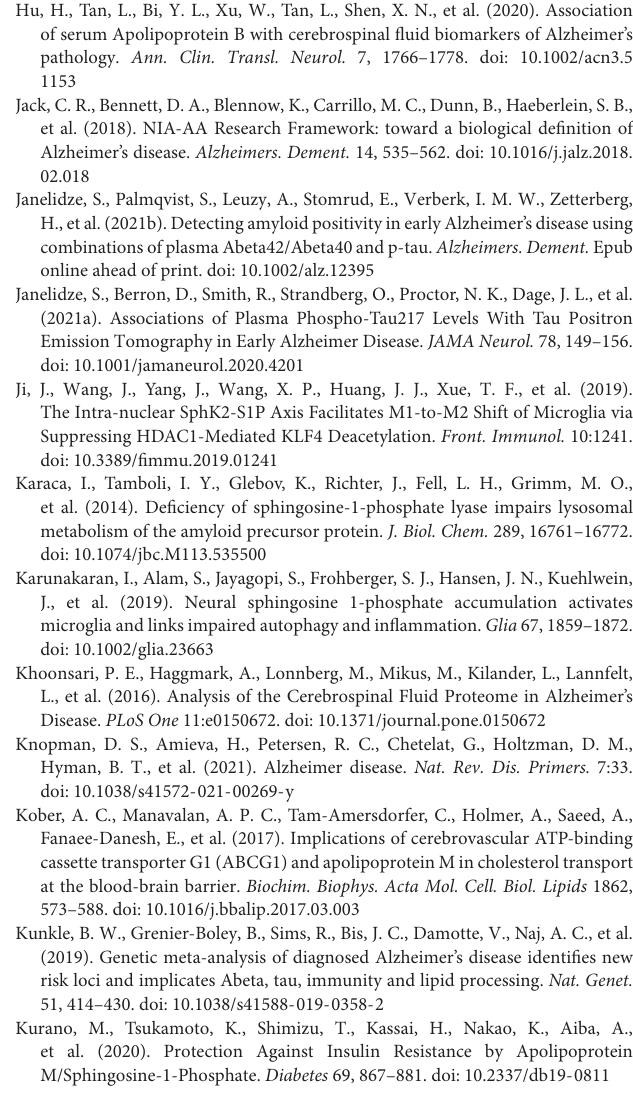
using Spearman’s rank correlation. p < 0.05 was considered the statistical significance. Supplementary Figure 4 | Correlations between plasma ApoM and its-derived indicators with representative blood biomarkers of AD in subgroup analysis based on APOE ε 4 status. ApoM, apolipoprotein M; p-tau217, tau phosphorylated at threonine 217; NfL, neurofilament light chain; CN, cognitively normal; AD, Alzheimer’s disease; TC, total cholesterol; TG, triglyceride; HDL-C, high-density lipoprotein cholesterol; LDL-C, low-density lipoprotein cholesterol. Correlation analyses were performed using Spearman’s rank correlation or Pearson’s correlation as appropriate. p < 0.05 was considered the statistical significance. Supplementary Figure 5 | Correlations between plasma ApoM and its-derived indicators with representative blood biomarkers of AD in subgroup analysis based on sex. ApoM, apolipoprotein M; p-tau217, tau phosphorylated at threonine 217; NfL, neurofilament light chain; CN, cognitively normal; AD, Alzheimer’s disease; TC, total cholesterol; TG, triglyceride; HDL-C, high-density lipoprotein cholesterol; LDL-C, low-density lipoprotein cholesterol. Correlation analyses were performed using Spearman’s rank correlation or Pearson’s correlation as appropriate. p < 0.05 was considered the statistical